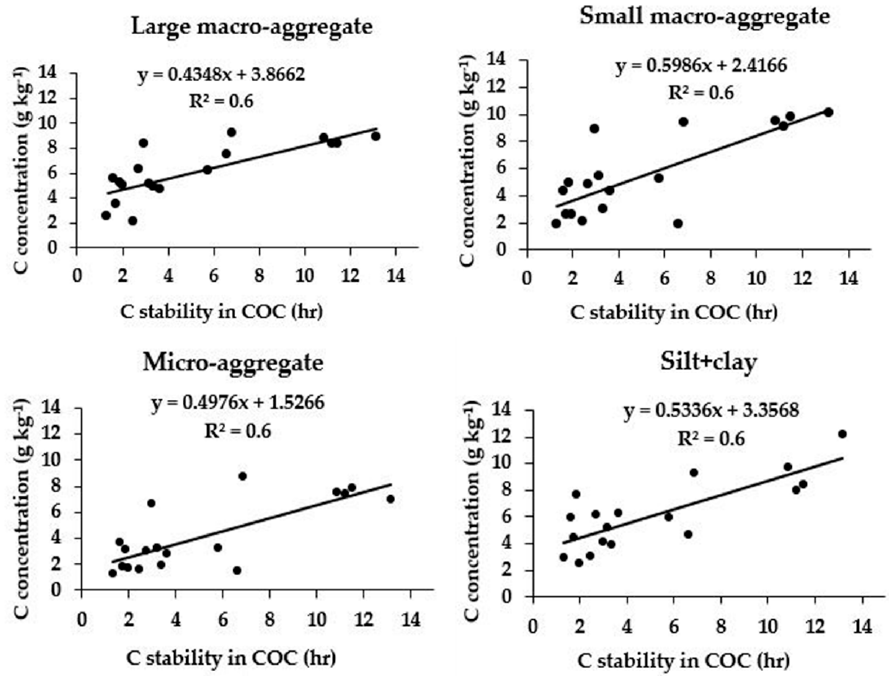
Figure 2. Relationship between C stability in clay–organic complex (COC) and aggregate-associated C ( n = 18; p ≤